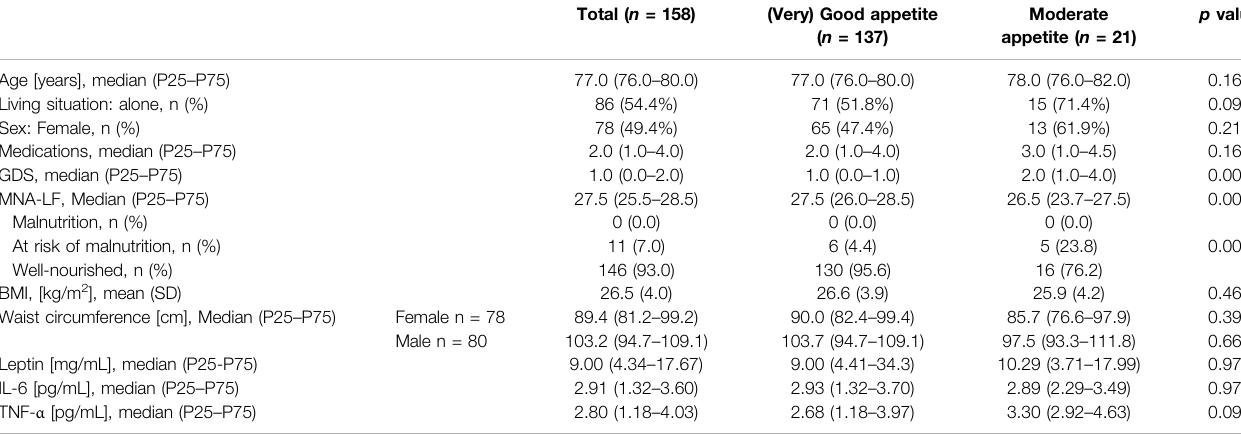
TABLE 1 | Participants ’ characteristics in the total sample size according to appetite.